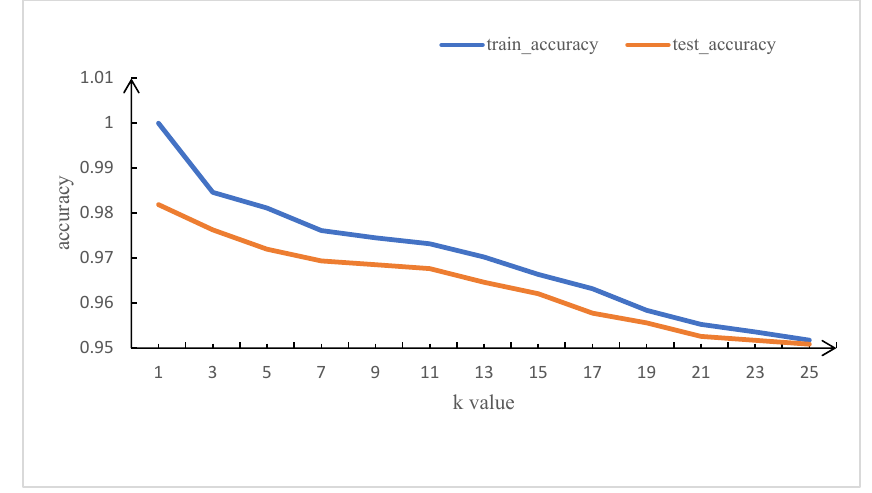
Figure 3. Average training and testing accuracy based on the X86 ‐ 32 dataset. Table 2. Single CPU architecture performance.